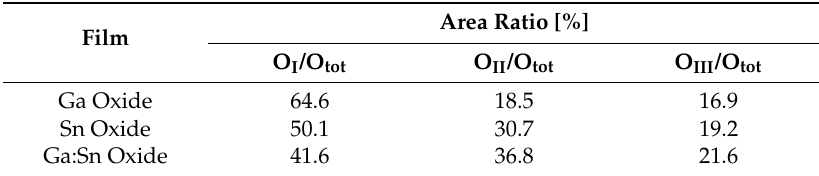
Table 1. Deconvolution results of O 1 s XPS (X-ray photoemission spectroscopy) spectra for the fabricated oxide films.